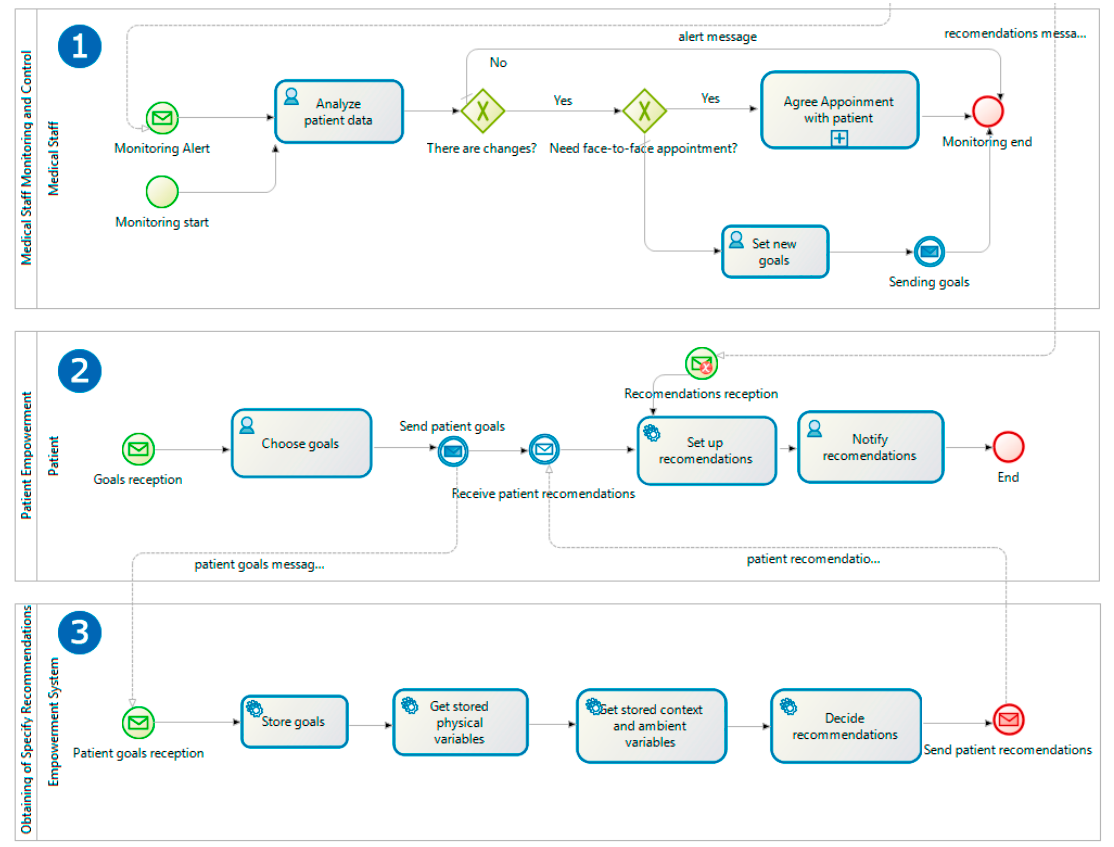
Figure 5. Process redesign (TO_BE). Patient empowerment cycle from medical staff control and monitoring cycle.